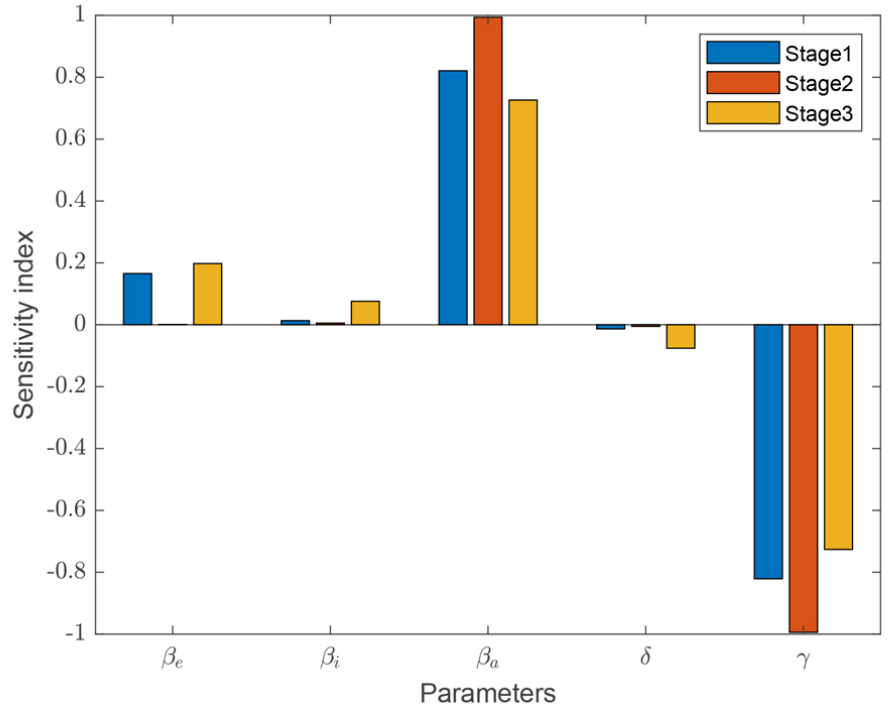
Figure 5. The sensitive indices determined with realistic data. Sensitivity indices of R 0 to the model parameters in the three